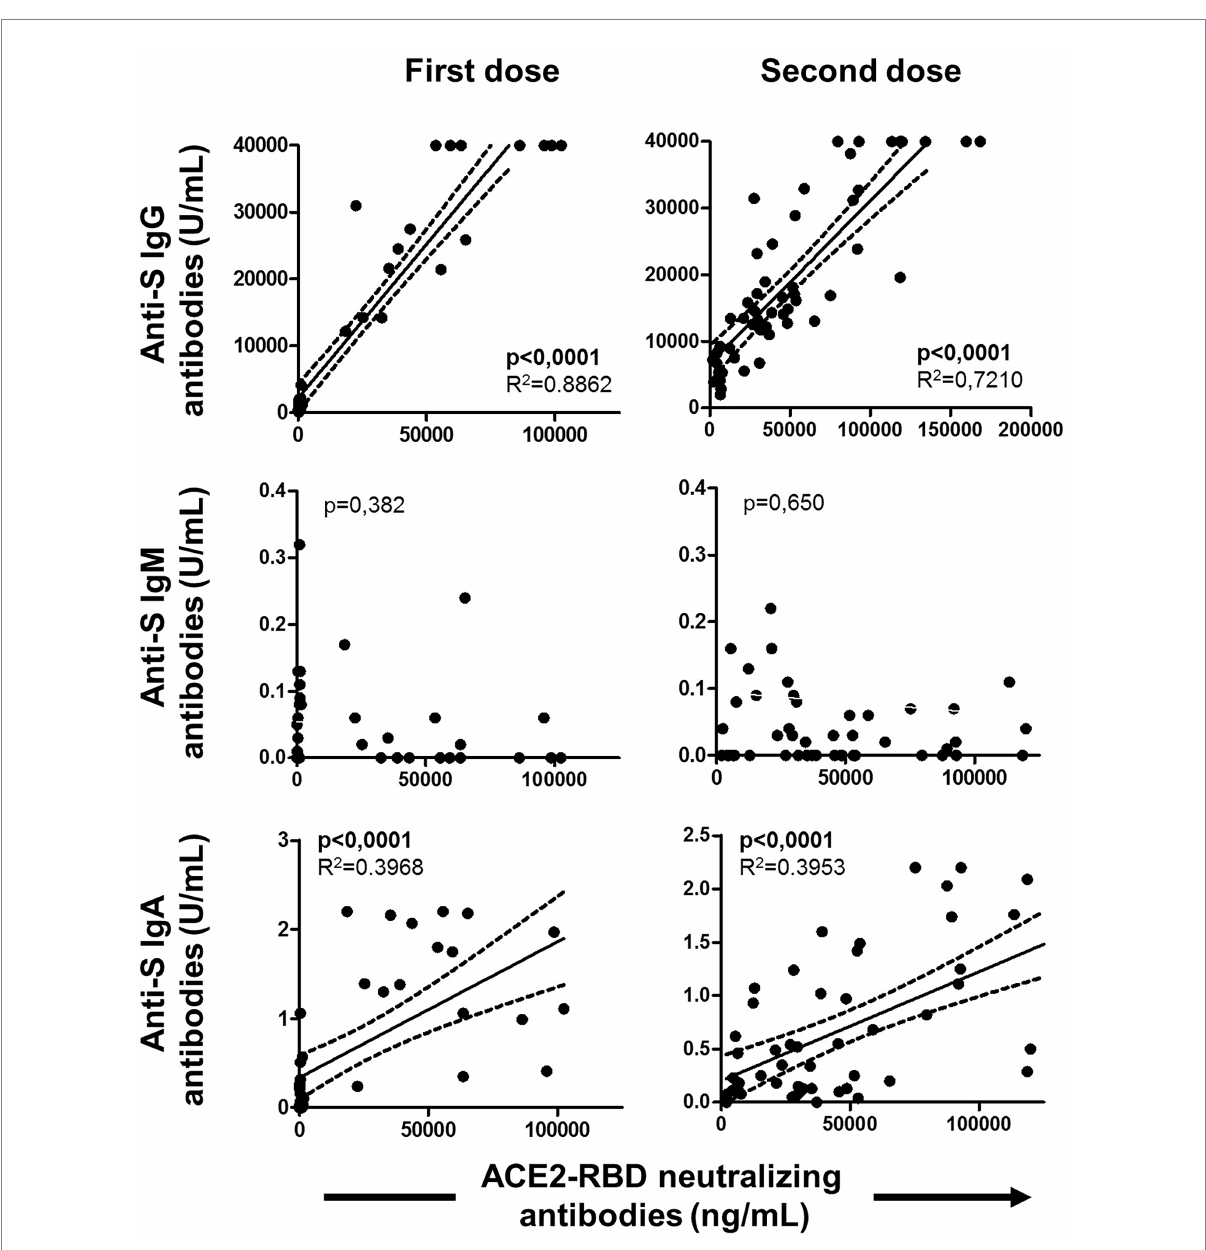
FIGURE 7 Associations of ACE2-RBD neutralizing antibodies with anti-S IgG, IgM and IgA antibodies after the first and the second doses of the vaccine. Pearson’s correlation r value and two-tailed p values are shown only with statistical significance ( p <